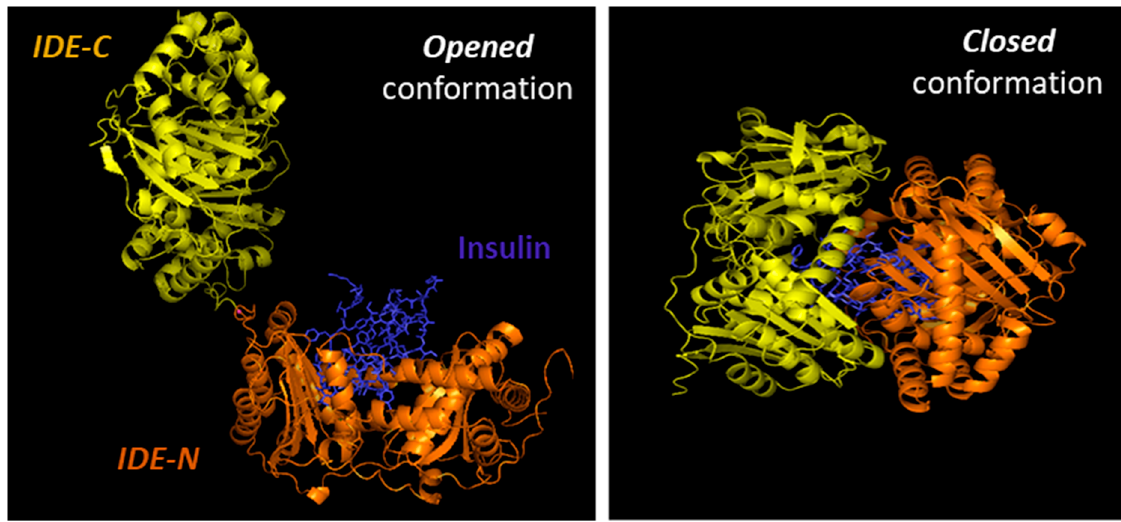
Figure 2. Cartoon illustrating the binding of insulin by IDE. IDE is in an equilibrium between “opened” and “closed” conformational states. In the absence of a substrate (e.g., insulin), IDE is preferentially in the closed conformation. IDE must adopt the open conformation for substrates to enter the internal chamber, whereas the protease must assume the closed conformation for proteolysis to occur. Release of the cleavage products requires a return to the open conformation.